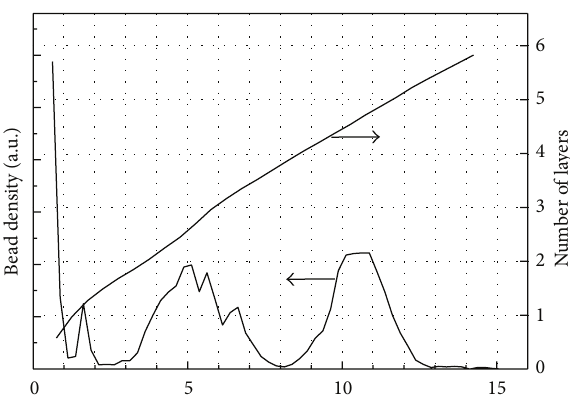
Figure 16: Density profiles of end beads and number of layers ( 𝑁 𝑝 = = 𝜀 𝑝 = 2𝜀 ) as a function of the distance from the wall 10 , and 𝜀 𝑝 𝑤 𝑏 ( 𝑧[𝜎] ).